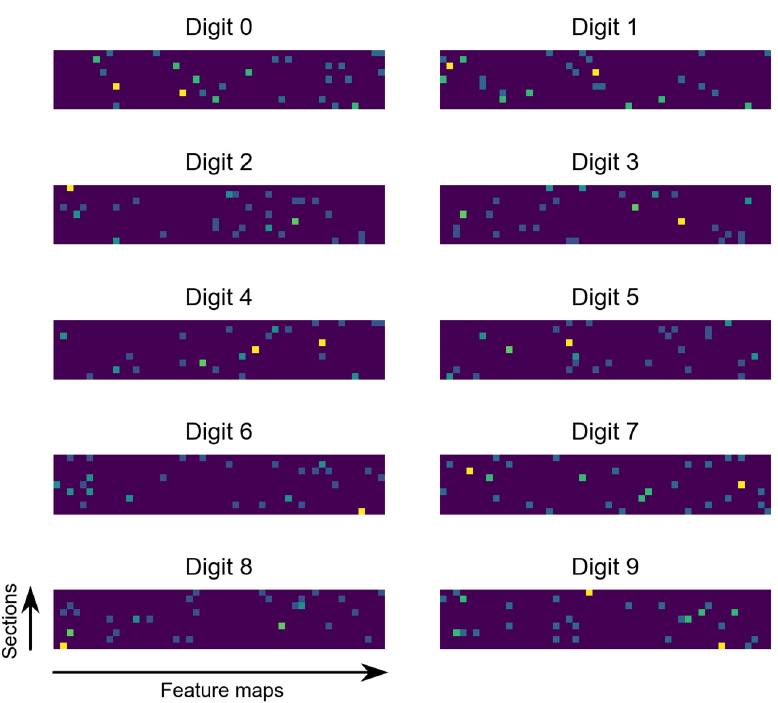
Fig 9. Visualization of SNN output. Each image represents the SNN output after a sample from the corresponding digit class is processed. The brightness of pixels represent the final membrane potentials of pooling neurons. Most pixels are dark in all images so the output is sparsely